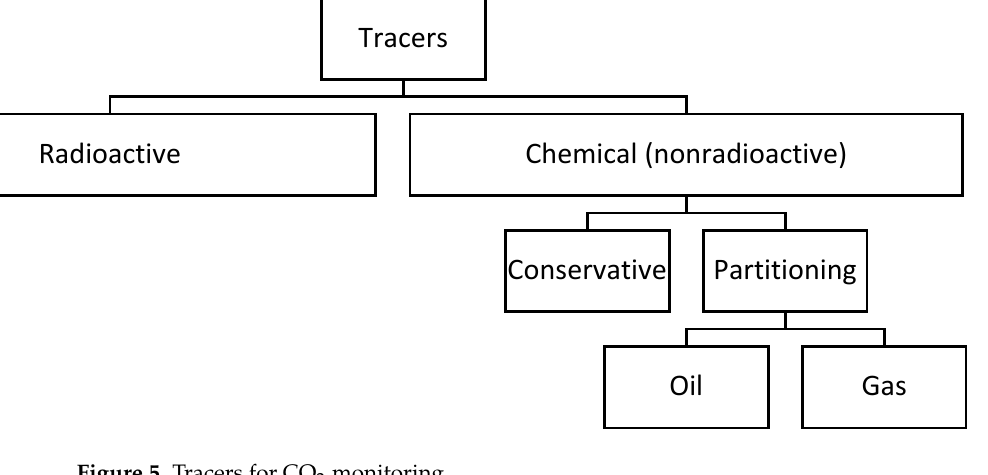
Figure 5. Tracers for CO 2 monitoring.